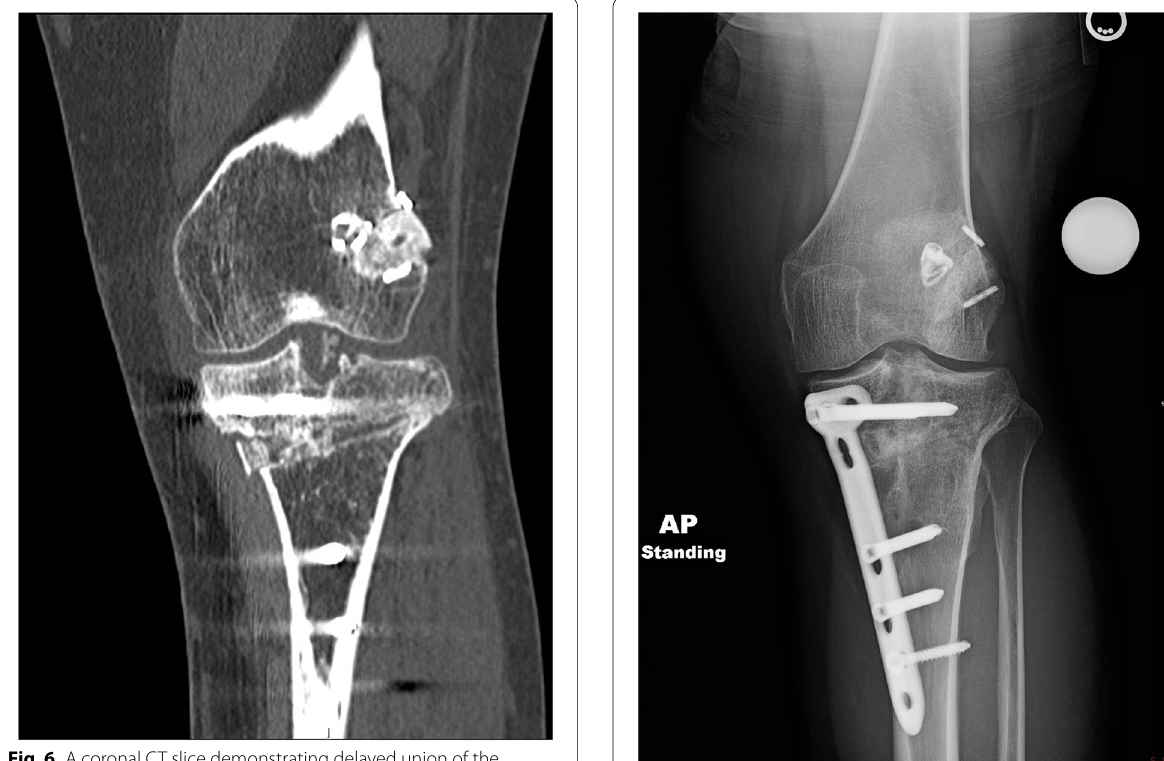
Fig. 6 A coronal CT slice demonstrating delayed union of the osteotomy site 4 months post-operatively after the patient’s revision osteotomy and ACL reconstruction